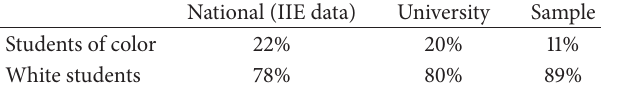
Source for national data: [4].